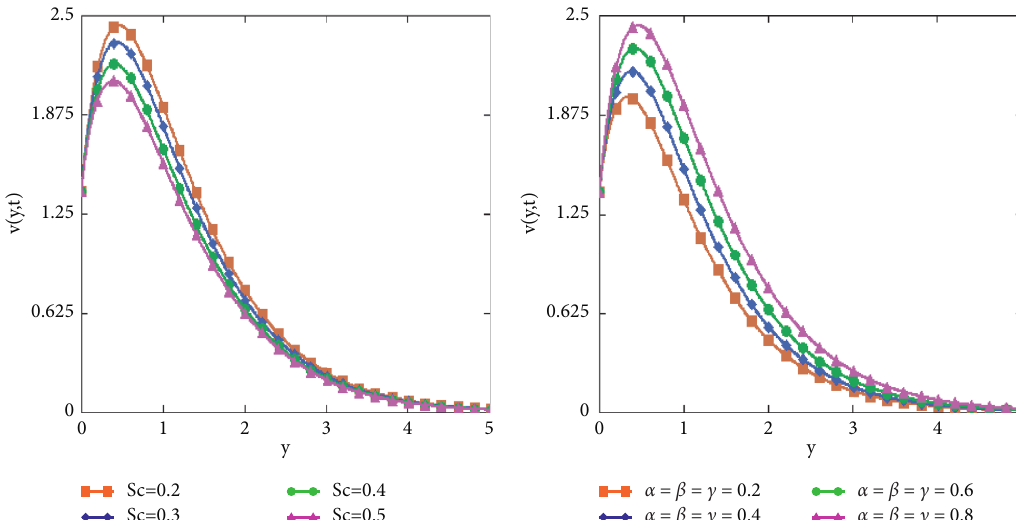
Figure 6: v ( y, t ) for distinct values of Sc and fractional parameters at R � 1 . 4 , Q � 0 . 4 , Gr � 9 , Gm � 6 ,M � . 85 ,B � 0 . 2 , andPr � 4 . 0.